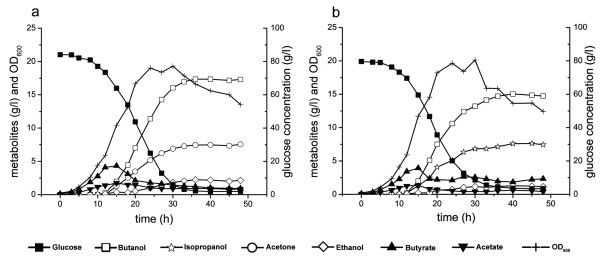
Fermentation profiles of (a) C. acetobutylicum
Rh8(pIMP1) and (b) C. acetobutylicum
Rh8(psADH). The fermentation was performed in CGM
culture under pH 5.0 with 100 μg/ml erythromycin at 37°C
in 7.5 L fermentor with an initial working volume of 3 L.
Data shown represent the averages of two independent fermentations.